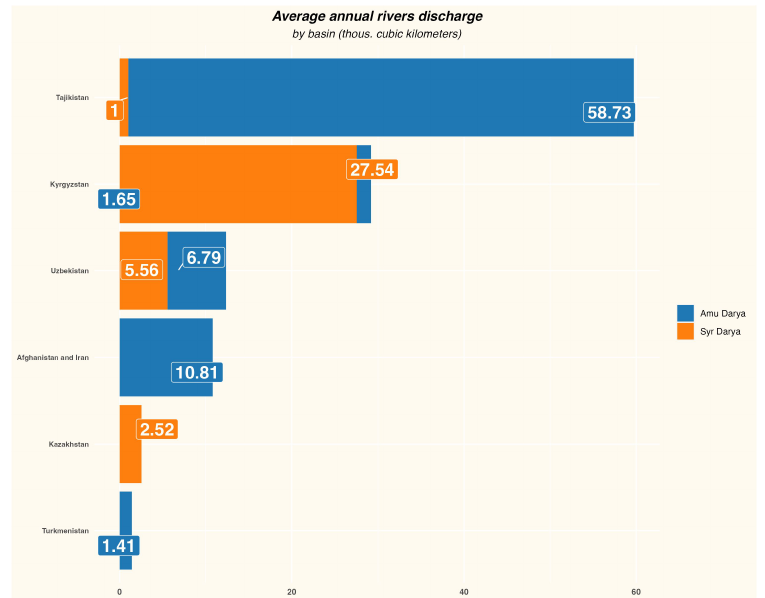
Figure 2. Average total rivers’ discharge in Aral Sea basin by country and river. Data source: Investicii